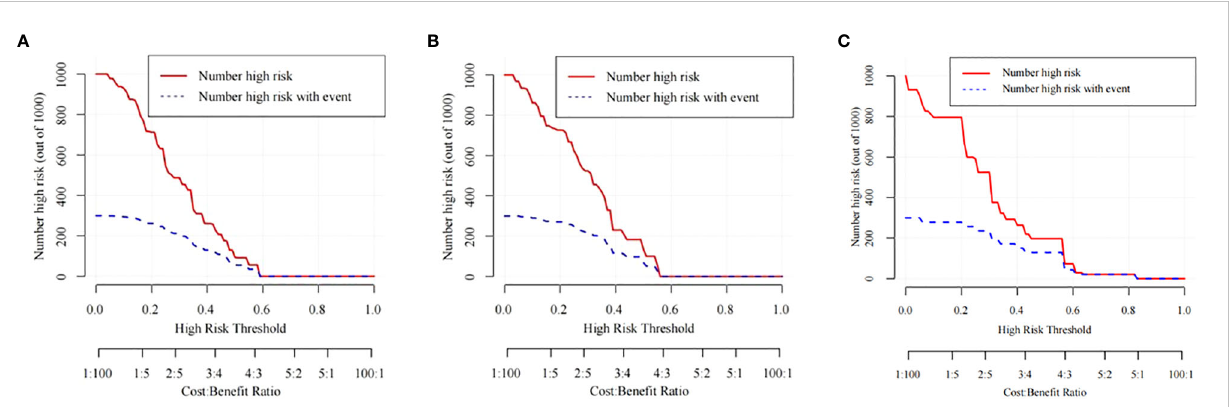
FIGURE 7 The CIC curves of the nomogram for predicting the LNM in the training cohort (A) , the internal validation cohort (B) , and the external validation cohort (C)